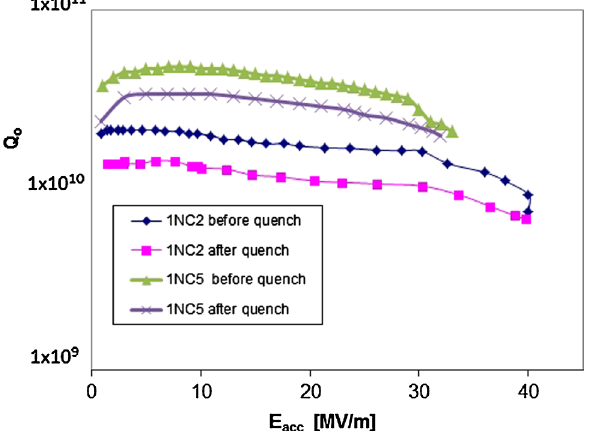
FIG. 38. Examples of rf results achieved in single-cell explo- sively bonded NbCu cavities. 1NC2 at 2K: Preparation and rf tests done at JLab: 180 μ m BCP, annealing at 800 °C, baking at 140 °C for 30 hours, HPR. 1NC5 at 1.8K: Preparation and rf tests done at KEK: CBP 50 μ m, BCP 110 μ m, HT 750 °C, EP 50 μ m,